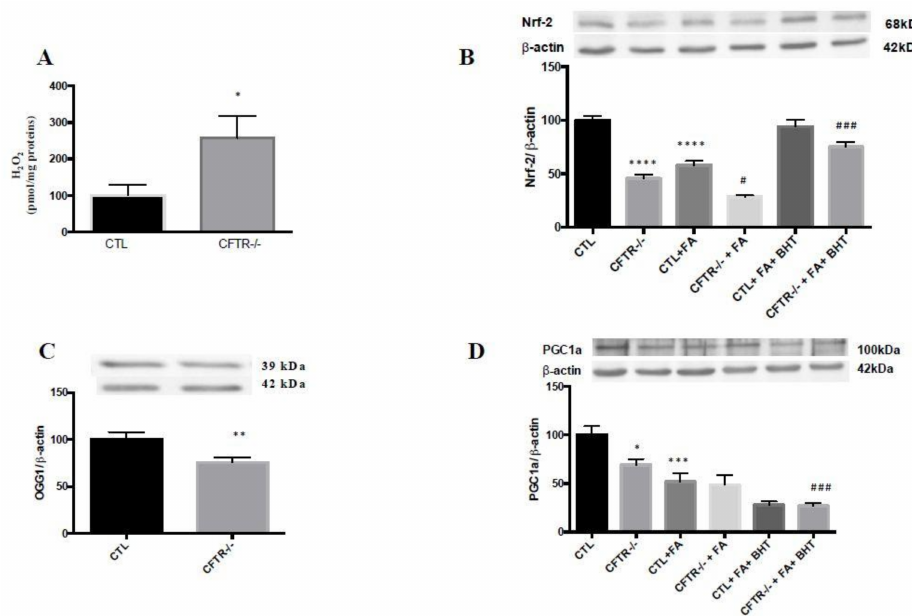
Figure 2. Impact of CFTR deletion on mitochondrial pro-oxidant and antioxidant defense in control and CFTR -/- cells. A fter cellular differentiation, Caco-2/15 cells were harvested, trypsinized and homogenized. ( A ) Mitochondrial H 2 O 2 was measured by a bioluminescence assay whereas Western blot served to estimate the protein mass of ( B ) nuclear factor (erythroid-derived 2)-like2 (Nrf2) in homogenate, ( C ) 8-oxoguanine DNA glycosylase (OGG1) in mitochondria, and ( D ) peroxisome proliferator activated receptor gamma coactivator-1-alpha (PGC-1 α ) in homogenate. Values are means ± SEM of 3–5 independent experiments, each done in triplicate. * p < 0.05, ** p < 0.01, *** p < 0.001, **** p < 0.0001 vs. CTL cells; # p < 0.05, ### p < 0.001 vs. CFTR -/- cells. CTR: control cells; FA: iron/ascorbate (200 µ M/0.5 mM); BHT: Butylated hydroxy toluene (0.5